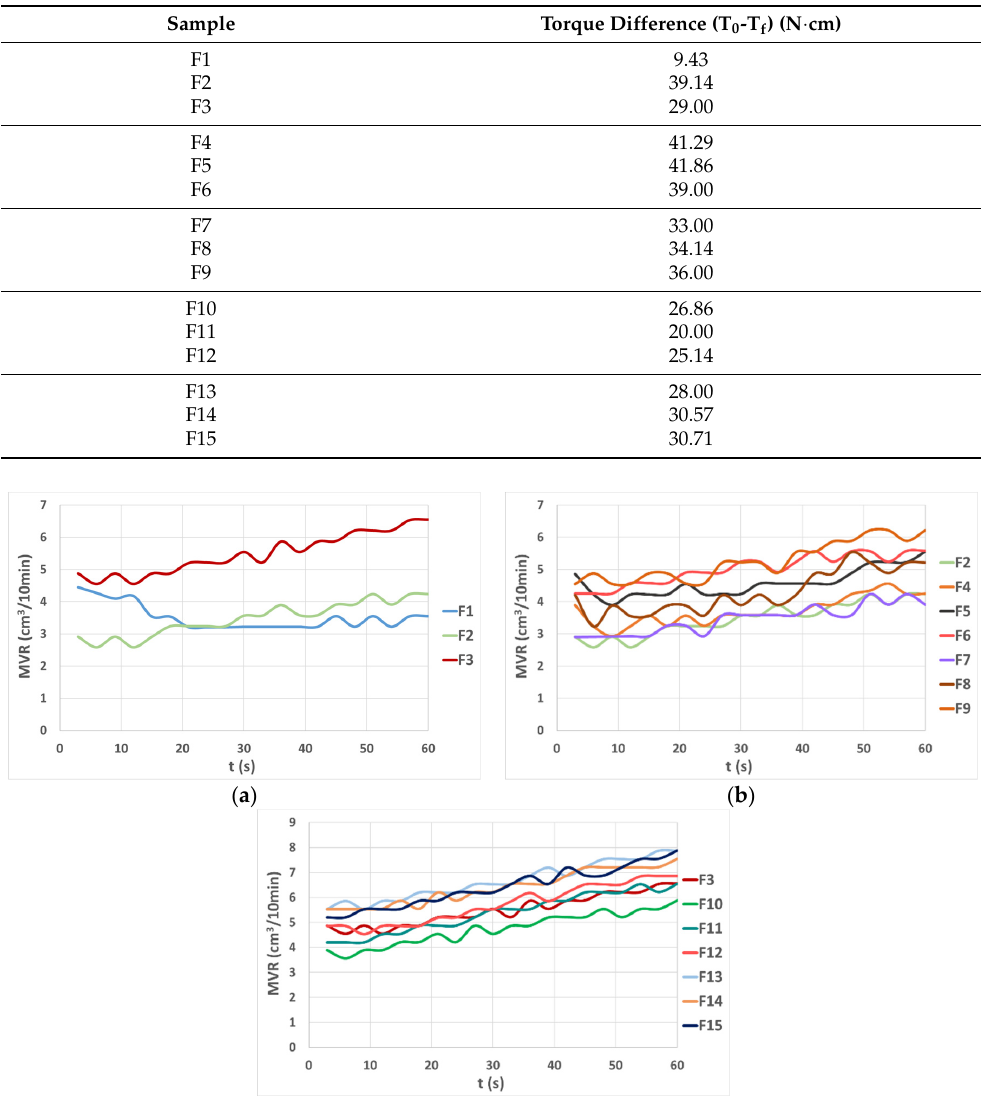
Table 3. Difference of torque values between the beginning (T 0 ) and the end (T f ) of the extrusion process for all the prepared samples. Higher torque differences represent a faster decay of torque over time.